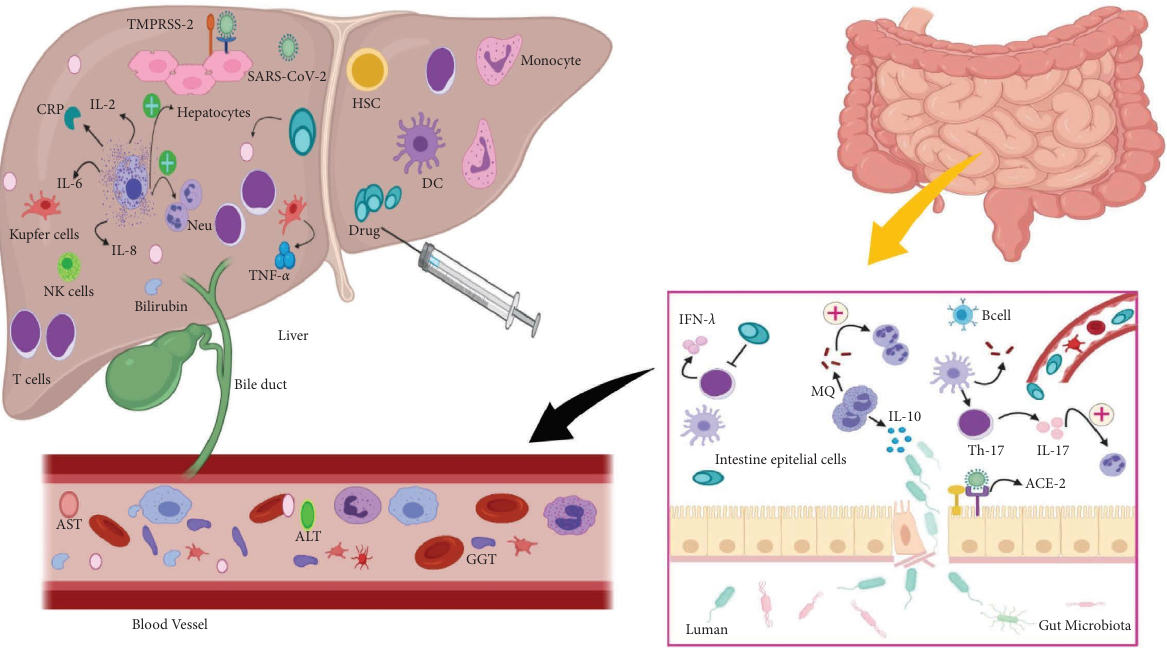
Figure 1: SARS-CoV-2 function in liver disorder. Te SARS-CoV-2 virus can either bind directly to its receptors on the surface of liver cells, such as ACE2 and TMPRSS2, or it can be indirectly through the efect of antiviral drugs or transmitted through the gastrointestinal tract and exert its infuence. Besides, increased intrinsic immune system activity such as macrophage cells and the production of proinfammatory cytokines and infection-induced lymphopenia exacerbates clinical symptoms and liver